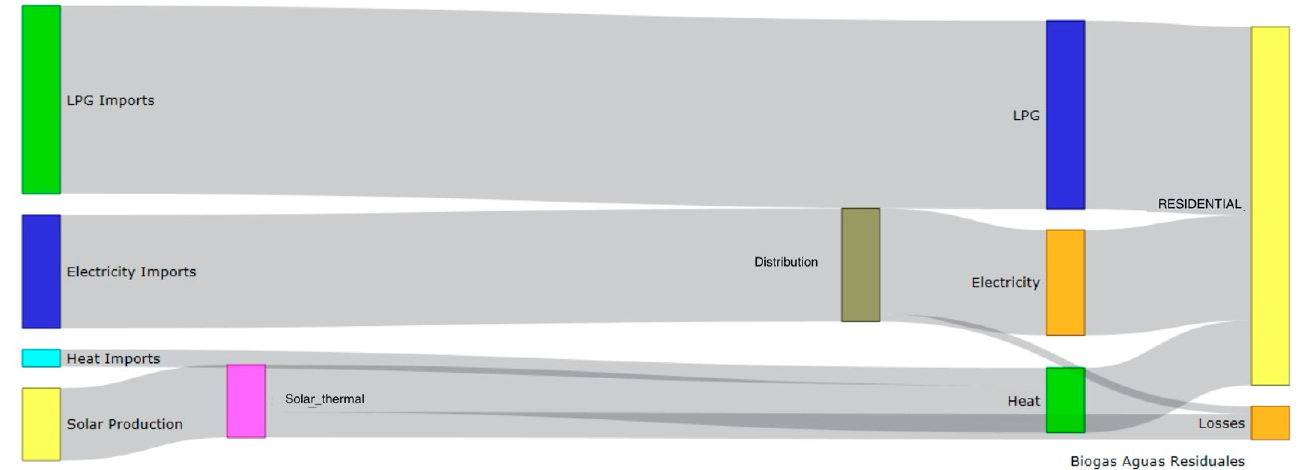
Figure 9. Scenario 2. Sankey diagram for 2030, residential sector (The figure shows the electricity losses given by the local distribution company. In addition, the losses of conversion of solar energy to heat are displayed. Losses due to the commercialization and distribution of LPG have not been included).